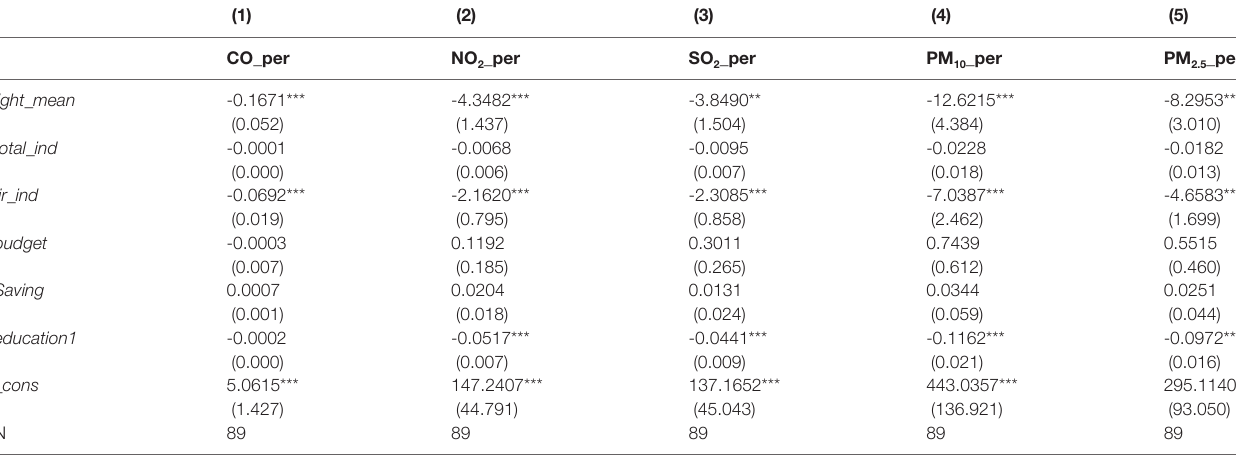
TABLE 9 | The impact of economic development on air pollutants intensity with replacing control